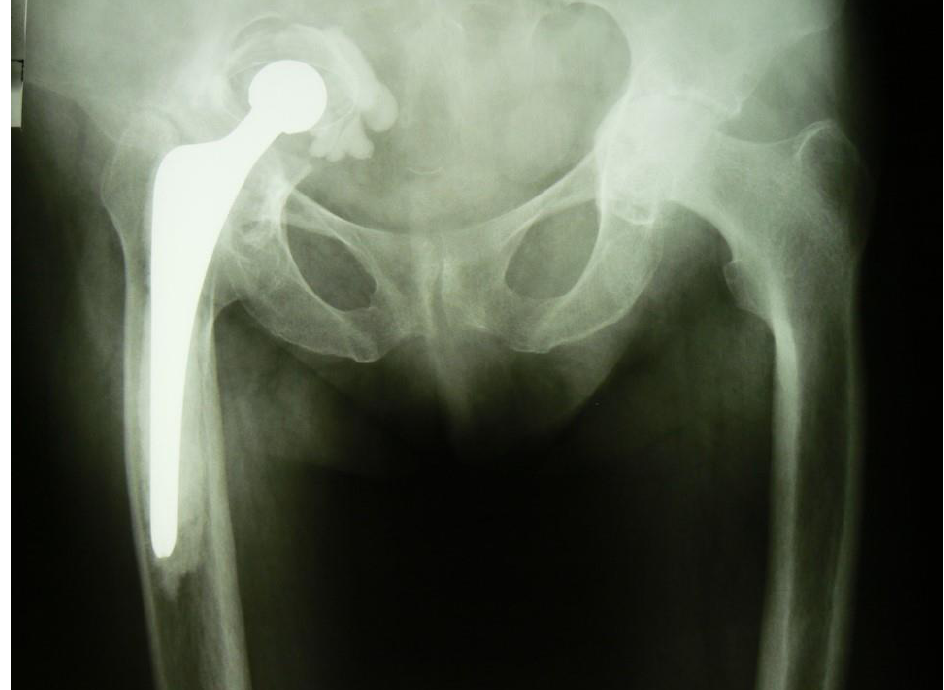
Figure 1. Protrusion of the prosthetic acetabulum, migration of the acetabular component, head and proximal part of the stem above the iliopectineal line. An antero-posterior (AP) radiograph of the pelvis and the hip joints.